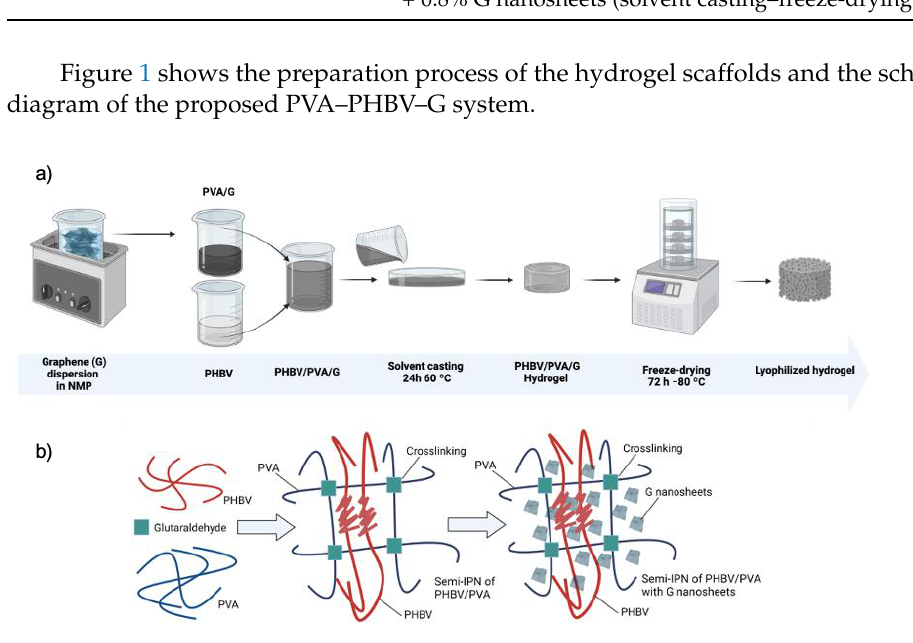
Figure 1. ( a ) Preparation process of the hydrogel scaffolds and ( b ) schematic diagram of the proposed PVA–PHBV–graphene hydrogel system. Created with Biorender.com.